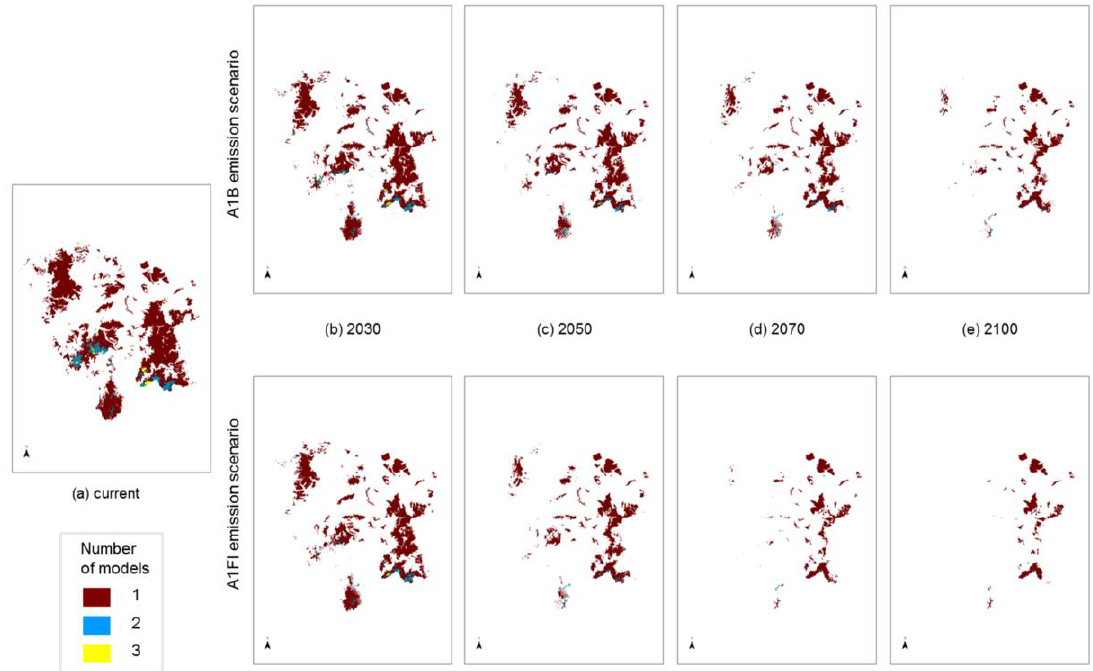
Figure 5. Modelled potential habitat for five threatened Macrozamia species in the Darling Downs region of Queensland, Australia under (a) current (historic) climate or with increasing annual mean temperatures under A1B and A1FI emission scenarios predicted in (b) 2030, (c) 2050, (d) 2070 and (e) 2100. Colours refer to the number of overlapping species models at a